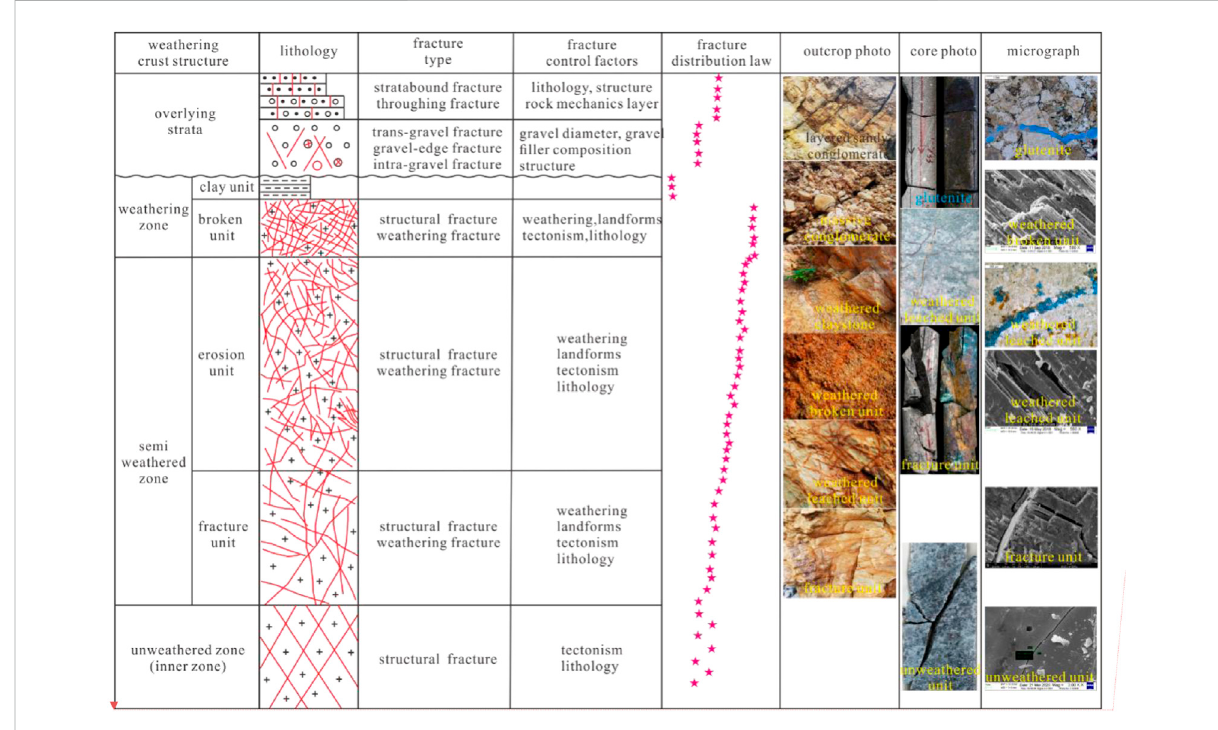
FIGURE 11 Weathered crust structure pattern and fracture distribution in